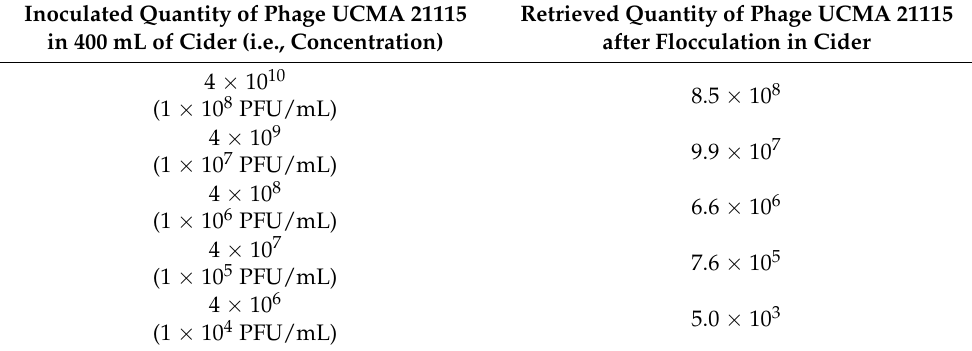
Table 3. Efficiency of iron-based flocculation to recover phage UCMA 21115 from cider samples. Inoculated Quantity of Phage UCMA